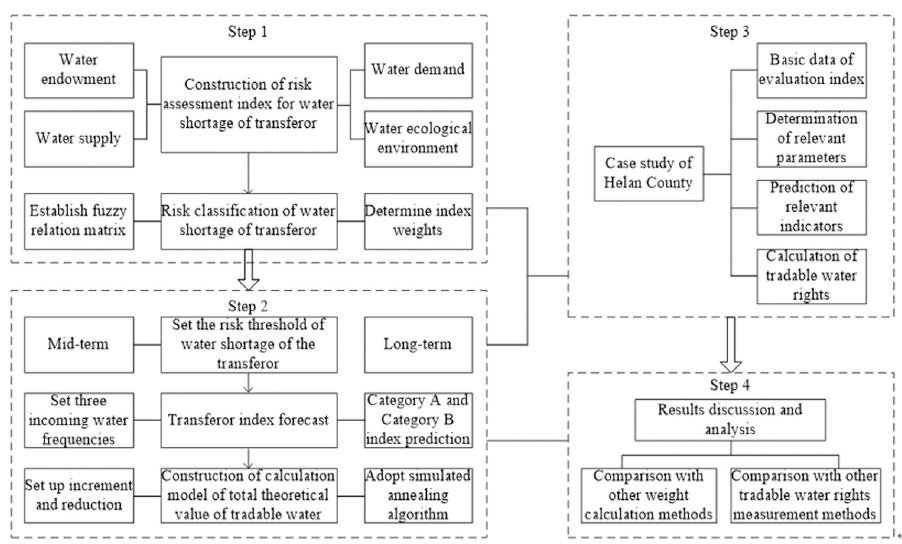
Fig 1. Basic flow chart of the proposed